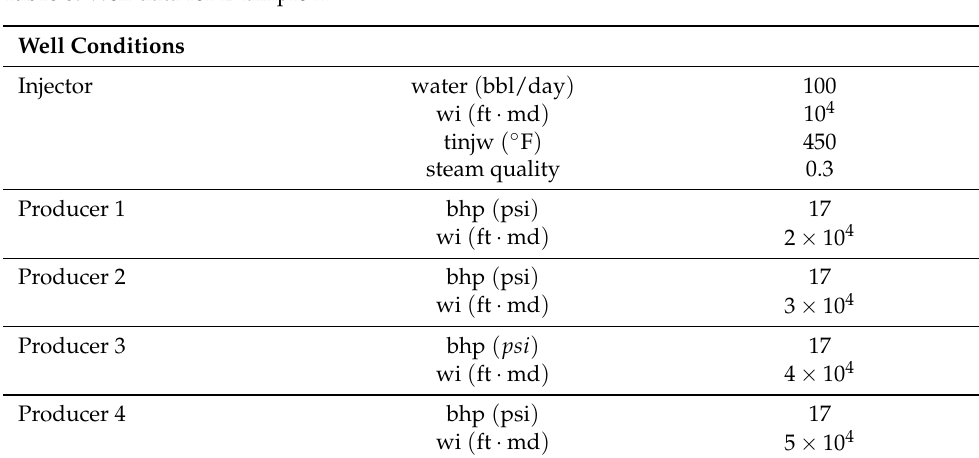
Table 8. Well data for Example